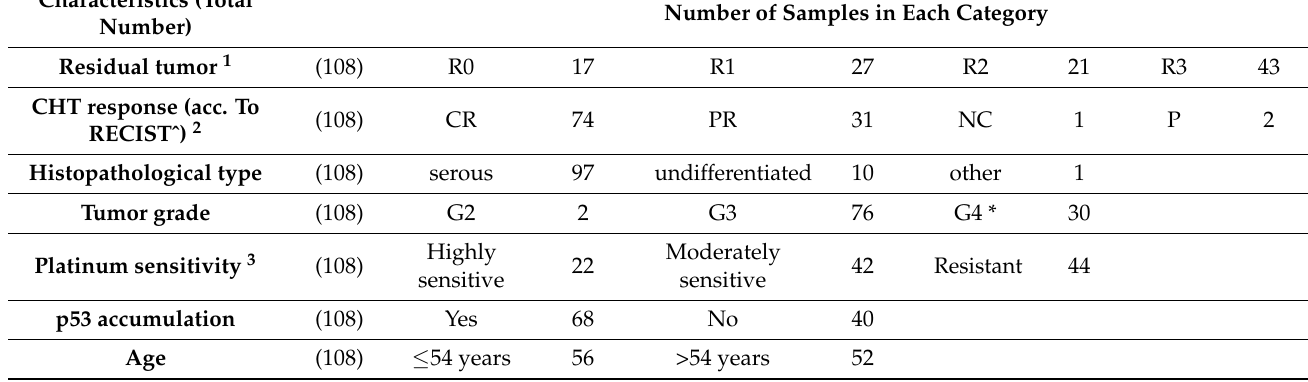
Table 3. Characteristics of patients and tumor